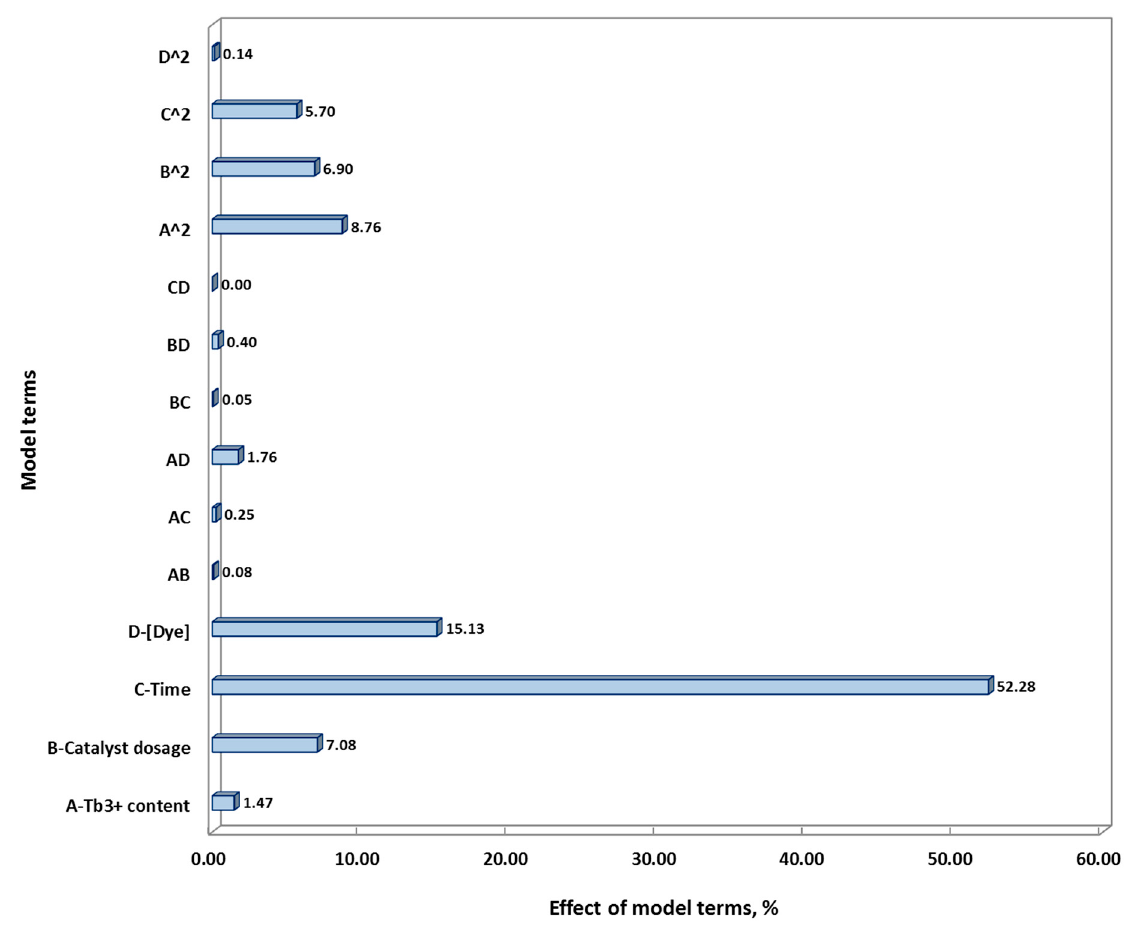
Figure 10. Percentage effect of model terms obtained using Pareto analysis.